Question: In a single sentence, describe what this figure presents.
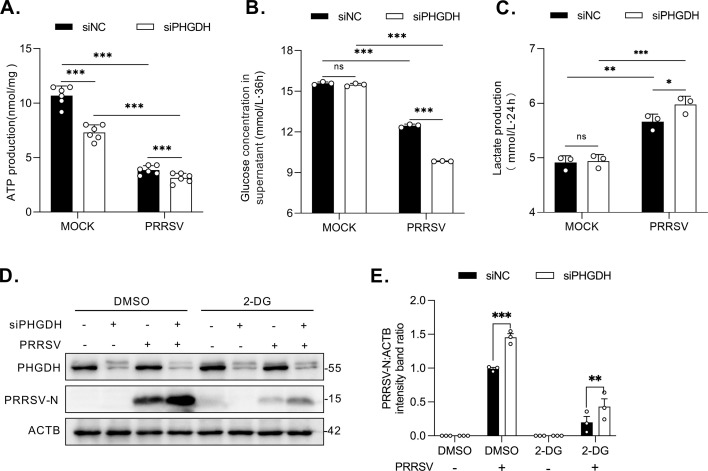
Answer: PHGDH knockdown induces an ATP deficit and a glycolytic shift, but glycolysis inhibition does not abolish enhanced PRRSV replication. ( A ) Intracellular ATP levels in mock- or PRRSV-infected siNC versus siPHGDH cells. ( B ) Glucose concentration/consumption in culture supernatants. ( C ) Lactate production in culture supernatants. ( D ) PRRSV N protein expression in siNC- or siPHGDH-transfected cells cultured with or without 10 μM 2-DG. ( E ) Quantification of panel D. Band intensities were quantified by ImageJ. Data are mean ± SD of three independent experiments; each dot represents one independent replicate ( n ≥ 3). Statistical significance was determined using the two-tailed Student’s t -test (for panels A – E ), * P < 0.05; ** P < 0.01; and *** P < 0.001.